Question: Summarize what this figure shows in one sentence.
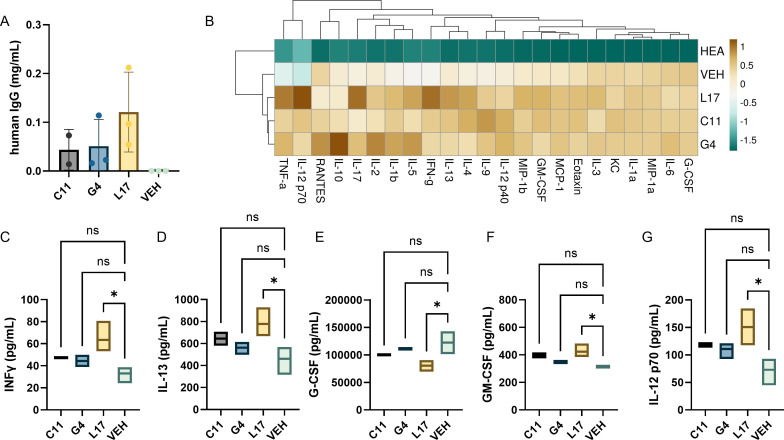
Answer: L17 alters serum cytokine responses following GAS infection. ( A ) Serum concentration of huMAbs compared to vehicle (VEH) measured 28 h post-infection. Data shown are mean ± SD ( n = 2, C11; n = 3 G4, L17, and VEH). ( B ) Heatmap of serum cytokine and chemokine concentrations across treatment groups. HEA denotes healthy, non-infected mice. Cytokine values were ln(x)-transformed and visualized by hierarchical clustering. ( C–G ) Box plots showing cytokines with statistically significant differences between treatment groups. Box size indicates max and min. Center lines indicate the mean. Statistical comparisons were performed by one-way ANOVA followed by Dunnett’s multiple-comparison test versus VEH control.